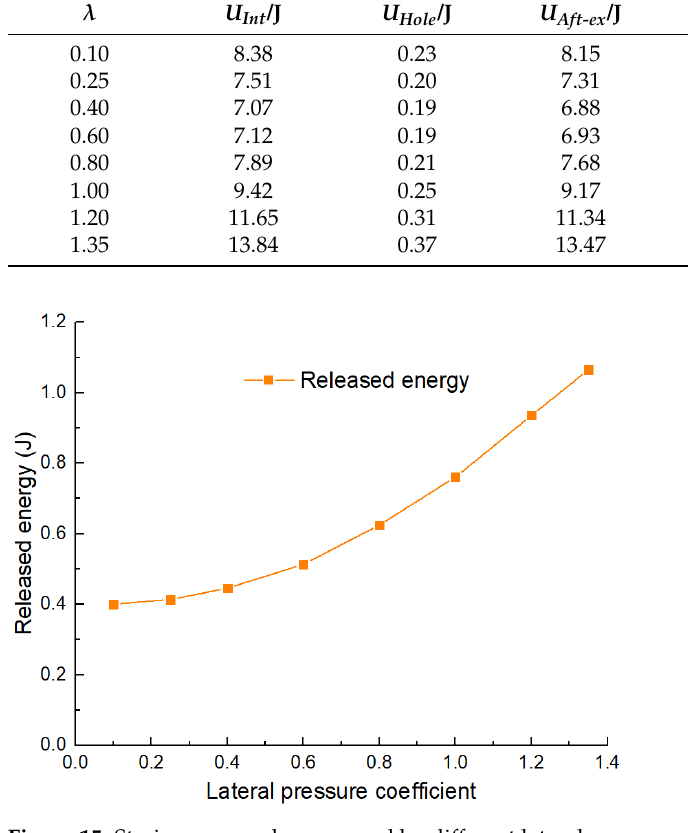
Figure 15. Strain energy release caused by different lateral pressure coefficient λ .